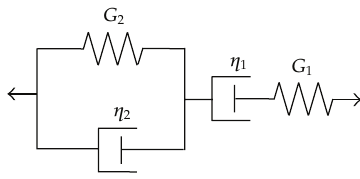
Figure 2: The Burgers viscoelastic